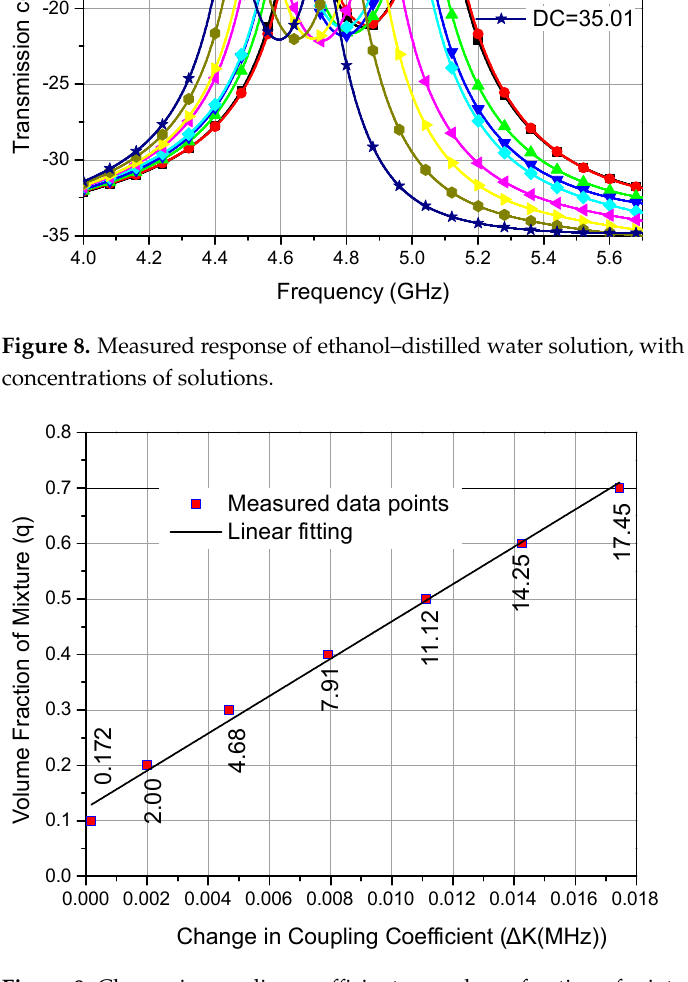
Figure 9. Change in coupling coefficient vs. volume fraction of mixture.